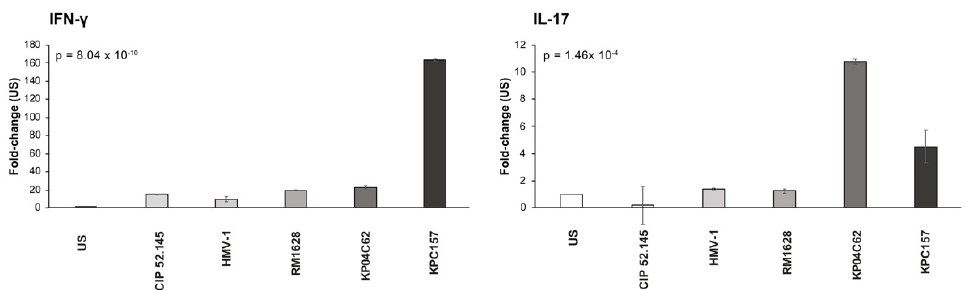
Figure 3. IFN- γ and IL-17 gene expression by pre-activated CD4 + T-cells. The bar-graph shows data (mean ± SE) of three different experiments. Data are expressed as fold-change with respect to unstimulated (US) cultures; the global p -value obtained by ANOVA is reported.